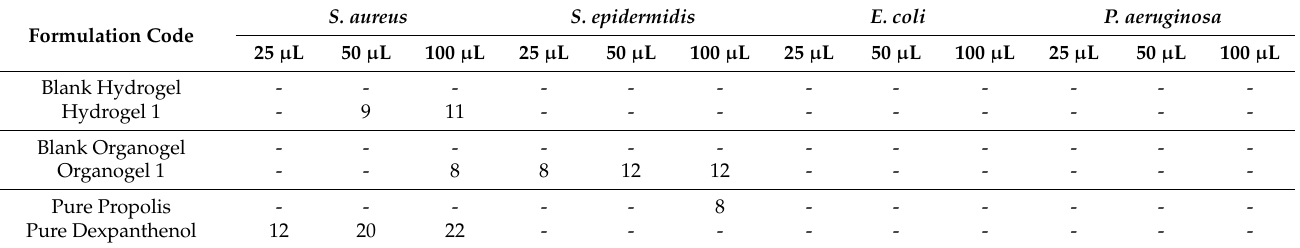
Table 8. Antimicrobial activity results from hydrogels, organogels, pure propolis, and pure